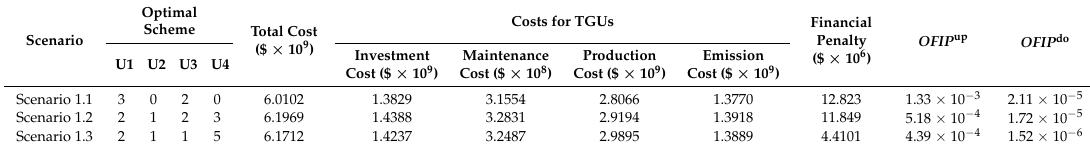
Table 5. Optimal schemes and costs on the effect of reliability constraints.